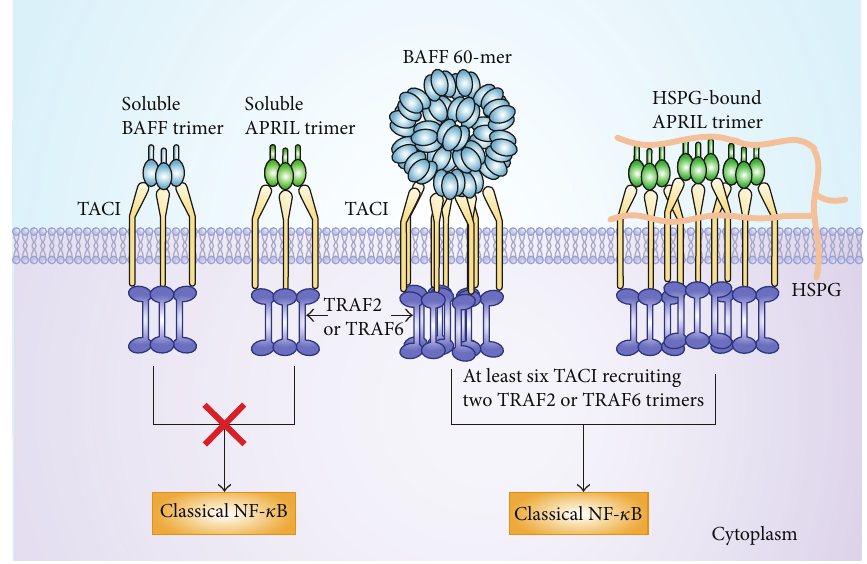
Figure 1: The forms of ligands to activate TACI. Both the BAFF 60-mers and multimerized APRIL are able to activate TACI; however, BAFF trimers and APRIL trimers cannot activate TACI. Because at least two TRAF trimers need to associate six TACIs to activate the classical NF- 𝜅 B